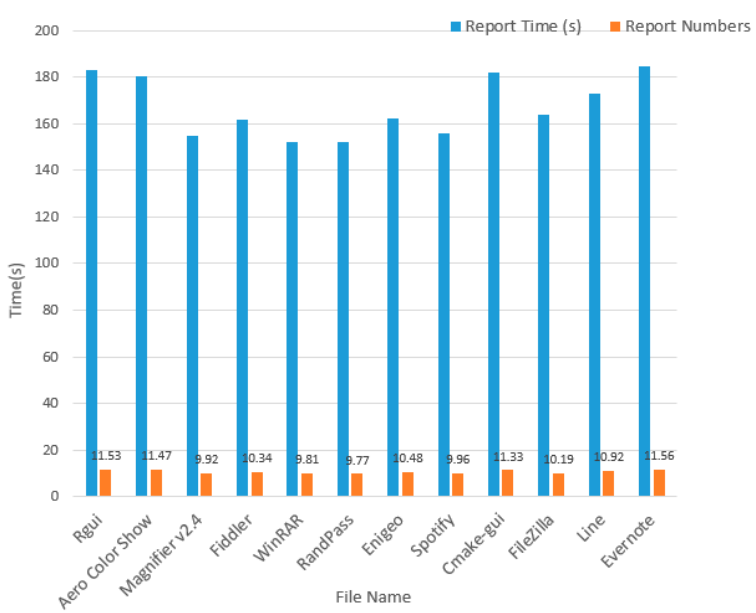
Figure 5. Average scan report time of 12 different test files and average numbers of queries that the 12 test files made to get their final scan reports.